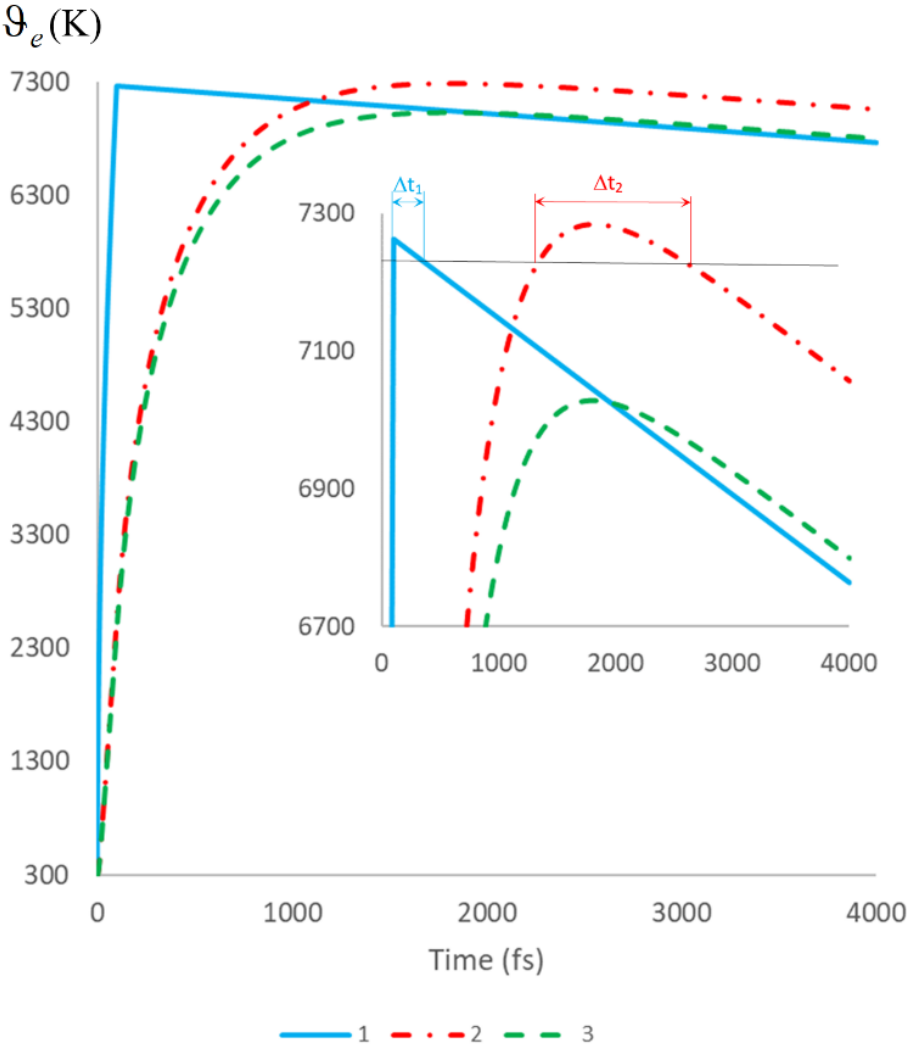
Figure 13. Electron temperature ϑ e kinetics, calculated for the duration of the irradiating pulse t p = 100 fs and the following parameters: curve 1—power density of the irradiating light P S = 250 MW/cm 2 , two-temperature model; curve 2— P S = 270 MW/cm 2 , model 2; curve 3— P S = 250 MW/cm 2 , model 2. The calculations correspond to the isothermal boundary condition with the same other parameters.